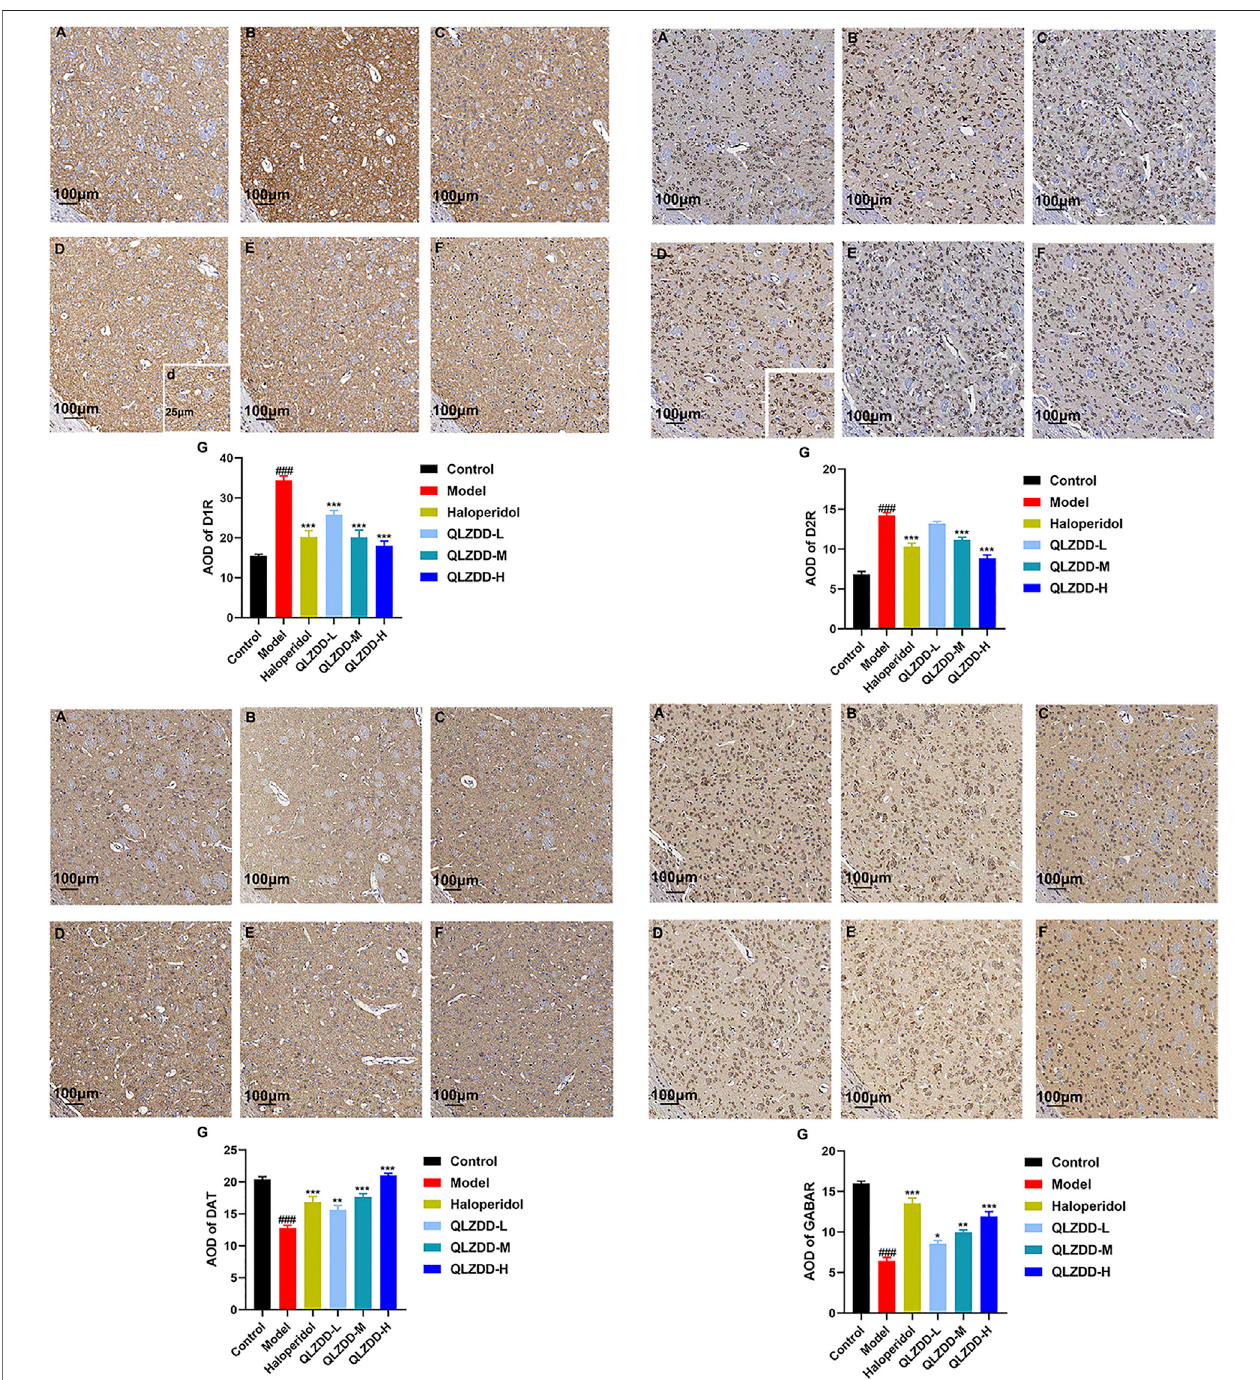
FIGURE 6 | The immunohistochemistry of D1R, D2R, DAT, and GABAR. (A) The control group, (B) the model group, (C) the haloperidol group, (D) the low- QLZDD-dosegroup, (E) themiddle-QLZDD-dosegroup, (F) thehigh-QLZDD-dosegroup,and (G) thehistogramoftheimmunohistochemistry.Alldatawereexpressed as mean ± SD ( n = 5 mice). One-way ANOVA was used to compare the data of the model group, the haloperidol group, and the QLZDD groups with the data of the control group. ### : p < 0.001 in comparison with the model group. ***: p < 0.001. Photos were taken with ×40 and ×10 magni fi cation.